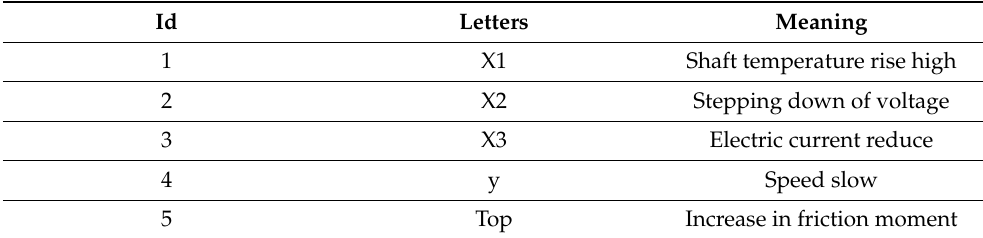
Table 1. FFTA indicates the letters in the fault tree.